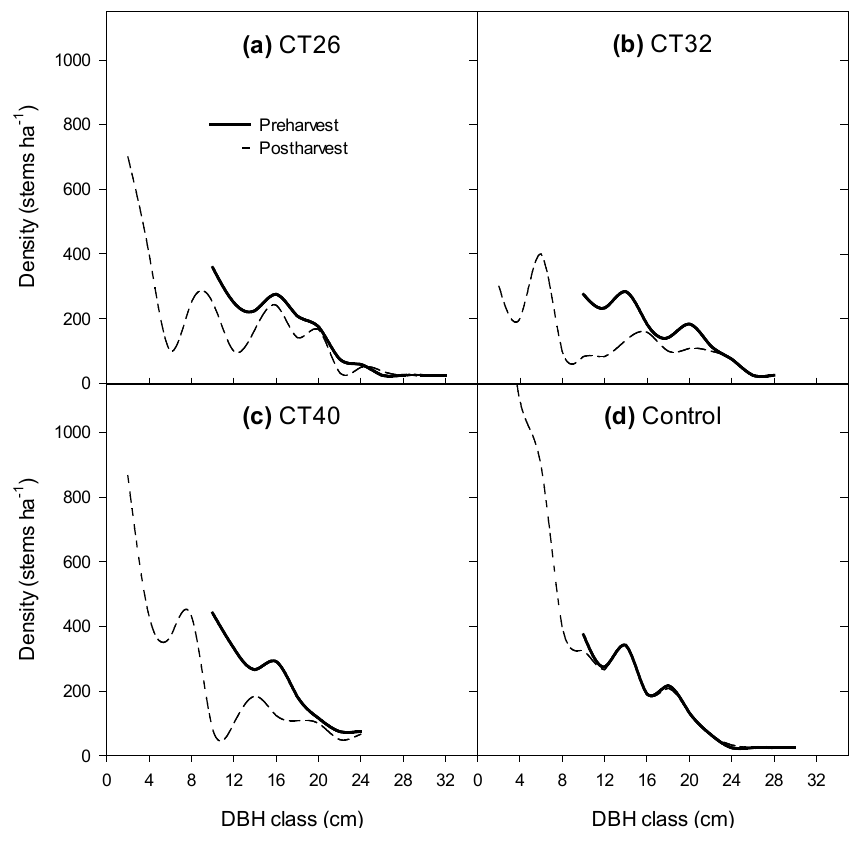
Figure 4. Preharvest and postharvest diameter distribution (2-cm classes) of four intensities of commercial thinning from below (26%, 32%, 40% and 0% merchantable basal area removals) ( a – d ). Lines are based on three replicates per